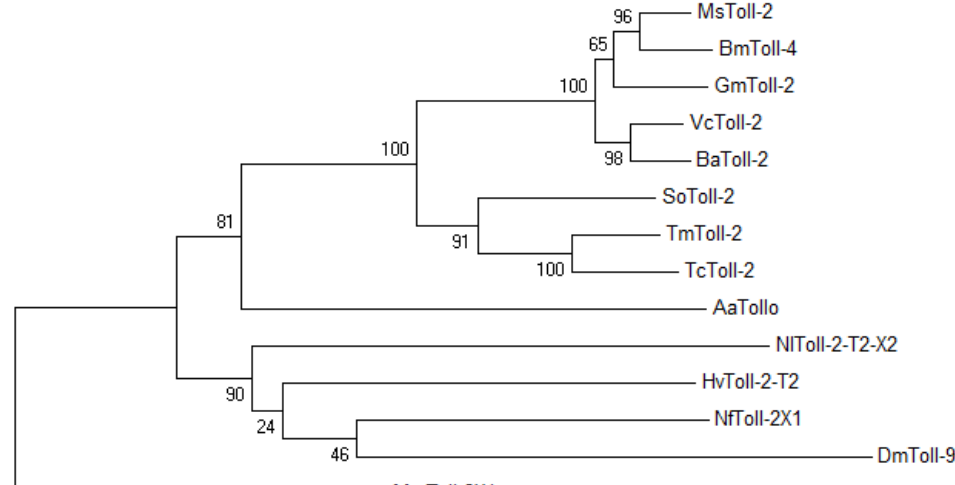
Figure 1. Molecular phylogenetic analysis of TmToll-2 , T. molitor Toll-2 (OP566501). The phyloge- netic tree was constructed using MEGA7 with the maximum likelihood method and 1000 bootstrap replicates (where numbers at nodes indicate bootstrap support). The percentage of trees in which the associated taxa clustered together is shown next to the branches. A neighbor-joining (NJ) tree was constructed on the basis of the protein sequences of Tc Toll-2, Tribolium castaneum toll-like re- ceptor 2 (XP_015837871.1); So Toll-2, Sitophilus oryzae toll-like receptor 2 (XP_030759691.1); Aa Tollo,